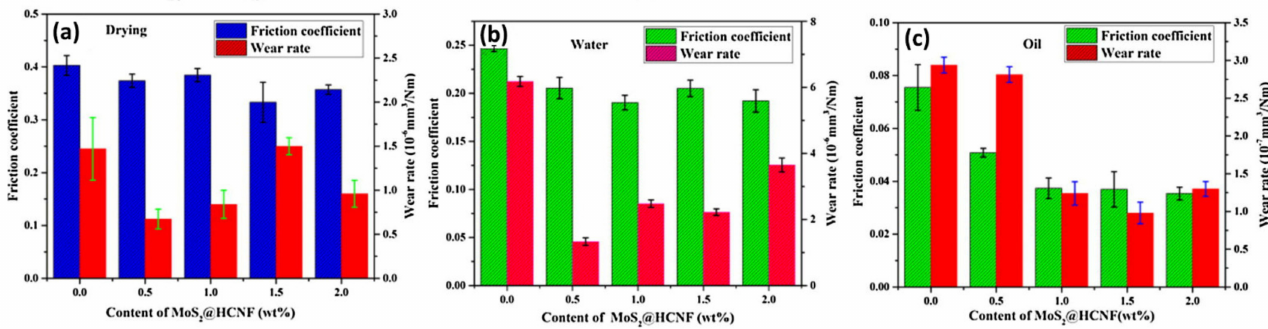
Figure 13. Friction coefficient and wear rate of the MoS 2 /HCNF/PI coating under ( a ) dry sliding, ( b ) water lubrication and ( c ) oil lubrication (Reproduced with permission from H. Yuan, S. Yang, X. Liu, Z. Wang, L. Ma, K. Hou, Z. Yang, J. Wang, Composites: Part A; published by Elsevier, 2017)